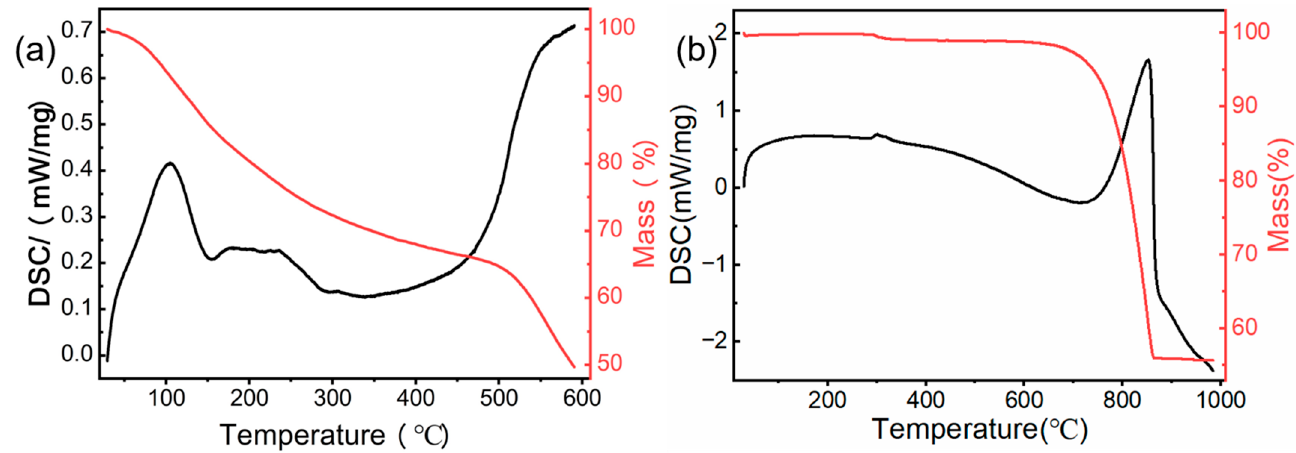
Figure 1. TGA and DSC curves of ( a ) chestnut shells and ( b ) snail